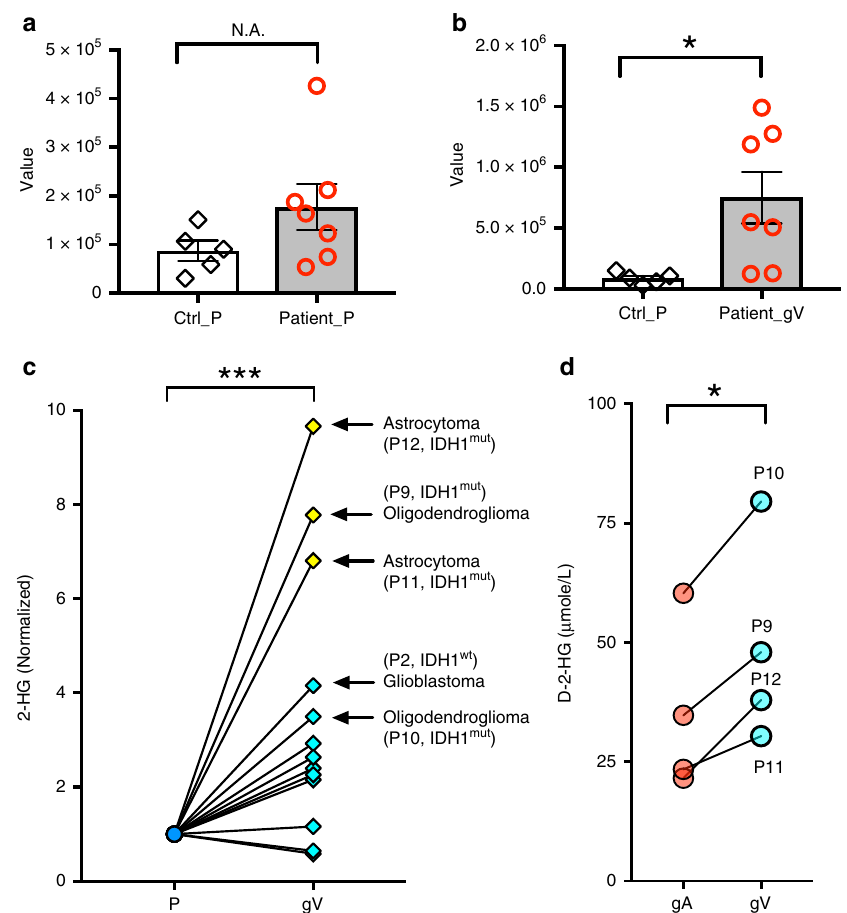
Fig. 5 Measurement of 2HG from human blood plasma. a – c The 2HG concentrations in glioma venous samples from patients with grade II and III gliomas were much higher than those with other gliomas (e.g., GBM). In a and b , Ctrl, n = 5; patients with oligodendroglioma and astrocytoma, n = 7, in c , all patients in Supplementary Table 1, n = 13. d Measurement of D-2HG in arterial, venous, and peripheral samples from these patients with IDH1 mutations (based on staining results, patients No. 9 – 12, also see Supplementary Table 1). D-2HG was signi fi cantly higher in venous samples than in arterial samples from the same patients. Ctrl_P, plasma from dorsal pedal vein of control subjects. Patient_gV, plasma from glioma veins of patients. gA samples from glioma arteries, gV samples from glioma veins, P samples from dorsal pedal vein. *** p < 0.001, * p < 0.05. Two-tailed non-paired t -test for a , b . Two-tailed paired t -test for c and d . All data were presented as mean ±